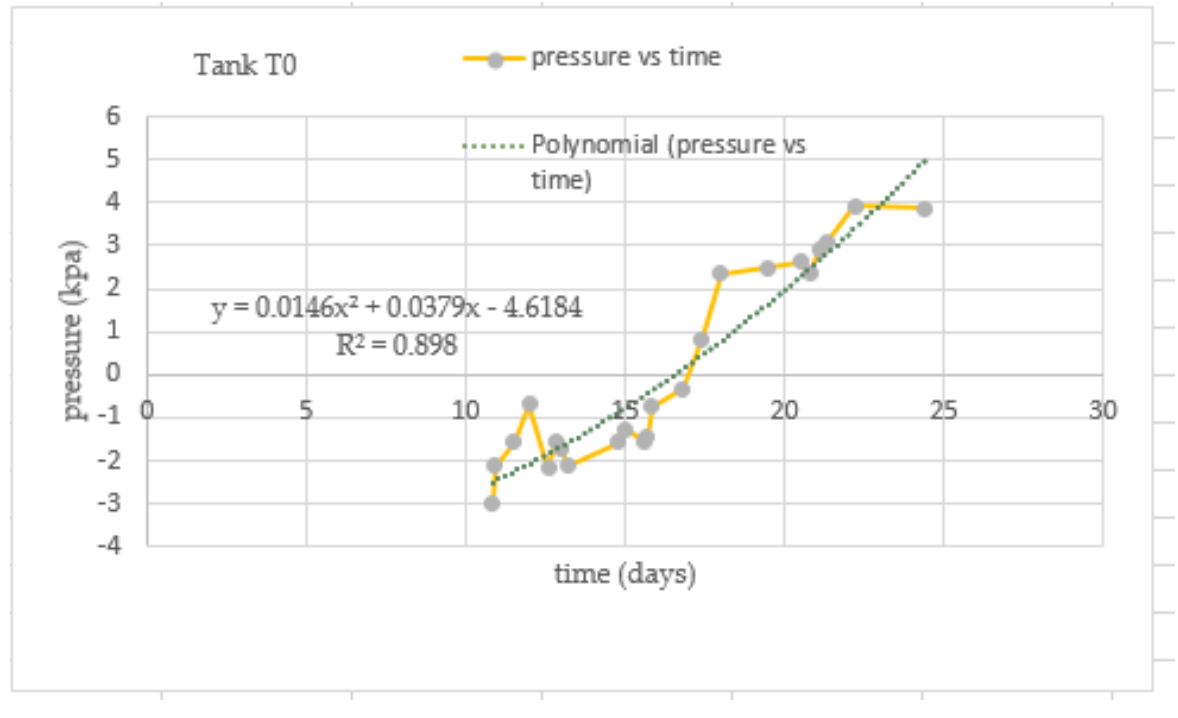
Figure 14. Pressure data measured in tank T0.